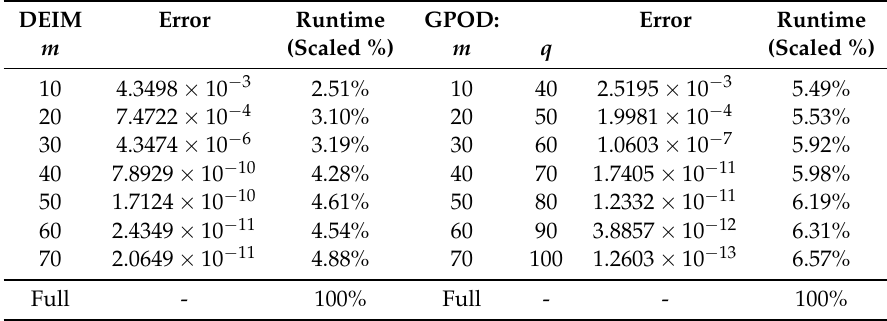
Table 3. [Test 1] Runtime and error of the POD-DEIM reduced system (left table) and POD-GPOD reduced system (right table) with POD basis with dimension k =